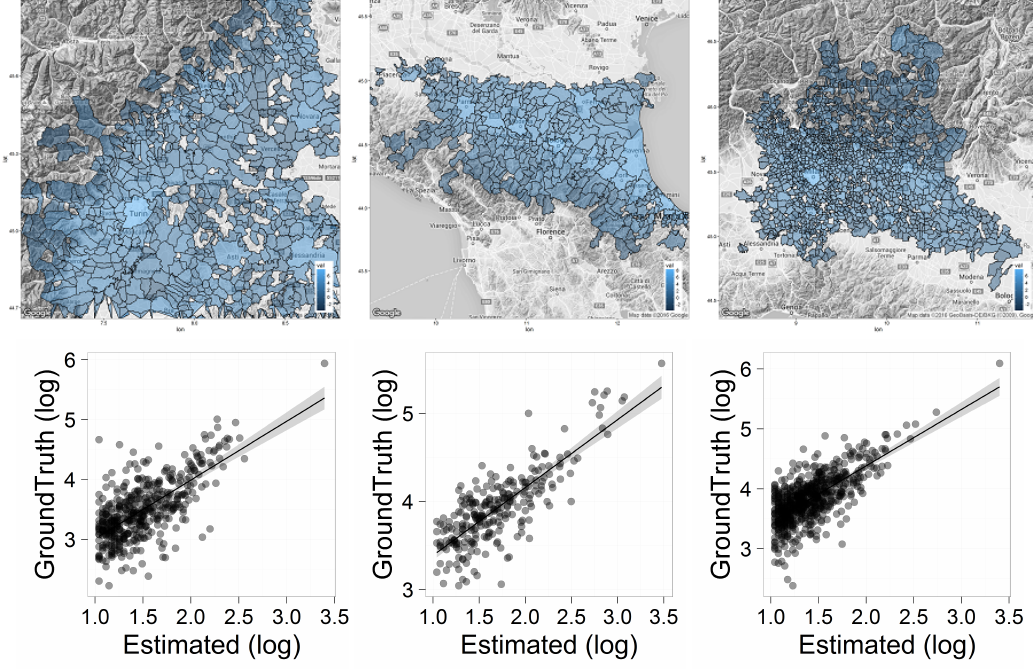
Figure 3. Density map for homes’ distribution and associated correlation with ISTAT Census in 2011. ( left ) Piemonte ( r 2 = 0.46). ( middle ) Emilia Romagna ( r 2 = 0.64). ( right ) Lombardia ( r 2 =